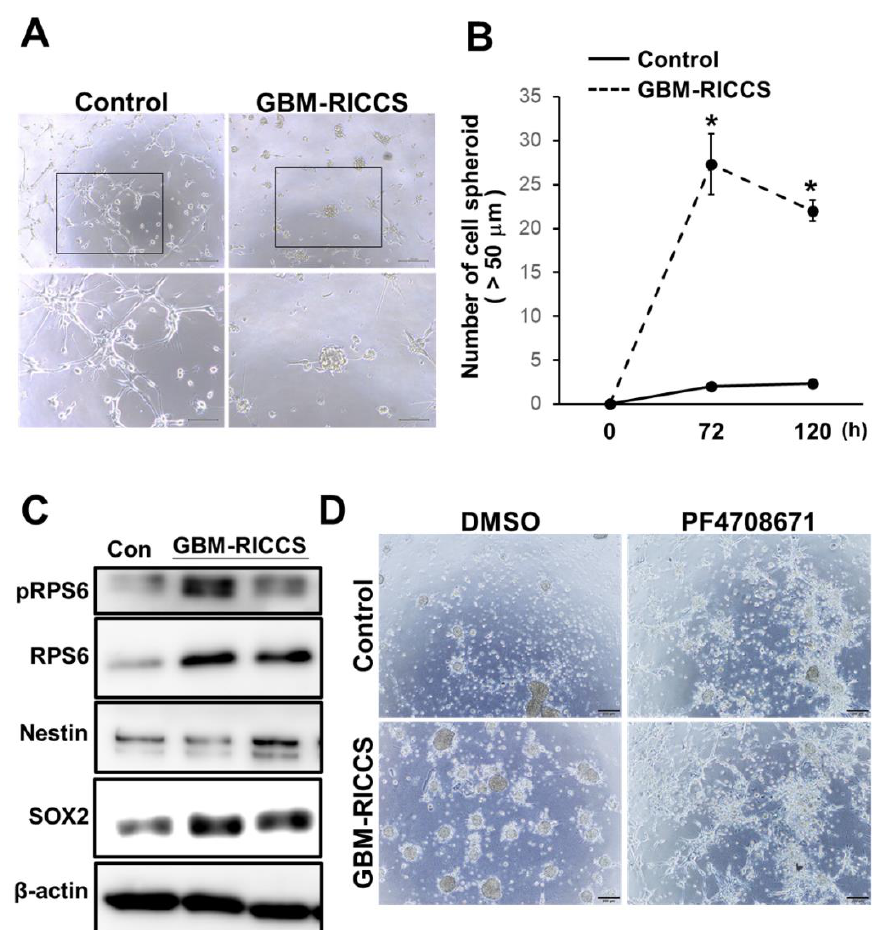
Figure 3. Effect of glioma-derived ribosome on stem cell characters in glioma cells. ( A ), Sphere- forming ability in GBM-RICCS induced by the incorporation of GBM ribosome or control (PBS). Bar: 100 µm (each down-scale picture), 200 µm (up-scale picture). ( B ), Stem cell characters were evaluated by sphere formation and the graph showing the number of spheres (>50 µm) cultured for 0, 72, and 120 h. ( C ), Western blotting showing the RPS6, pRPS6, and stem cell markers (Nestin and SOX2) in GBM-RICCS. ( D ), PF4708671 (RPS6 kinase inhibitor) treatment suppressed sphere-forming ability. Bar: 200 µm. * p < 0.05.